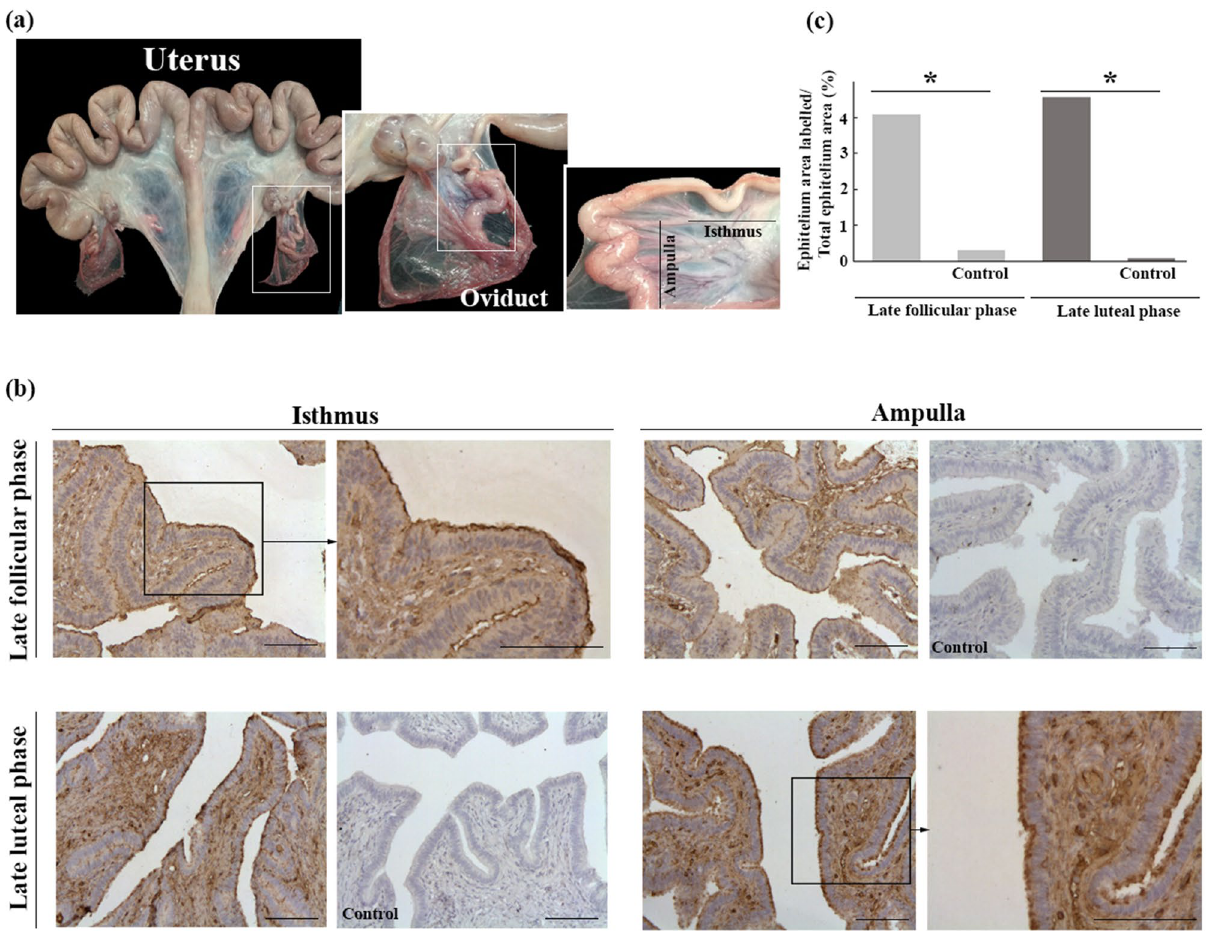
Figure 2. (a) Representatives images of a porcine female genital tract including the uterus and oviduct. Samples for the immunohistochemistry analysis were obtained from the ampulla and isthmus of the oviduct. (b) Immunohistochemical localization of haptoglobin in porcine oviduct in late follicular and late luteal phases. Haptoglobin labeling was detected at the epithelial cells (intense staining) of the isthmus and ampulla. No staining was observed in the control images (without primary antibody) of the isthmus and ampulla. Scale bar = 100 µm. (c) Quantification of the immunohistochemical signal of haptoglobin in late follicular and late luteal phases. Left Y-axis represents the reactive area in the oviductal epithelium with respect to the total epithelial area. (*) Between columns of the same phase indicates significant differences (p <